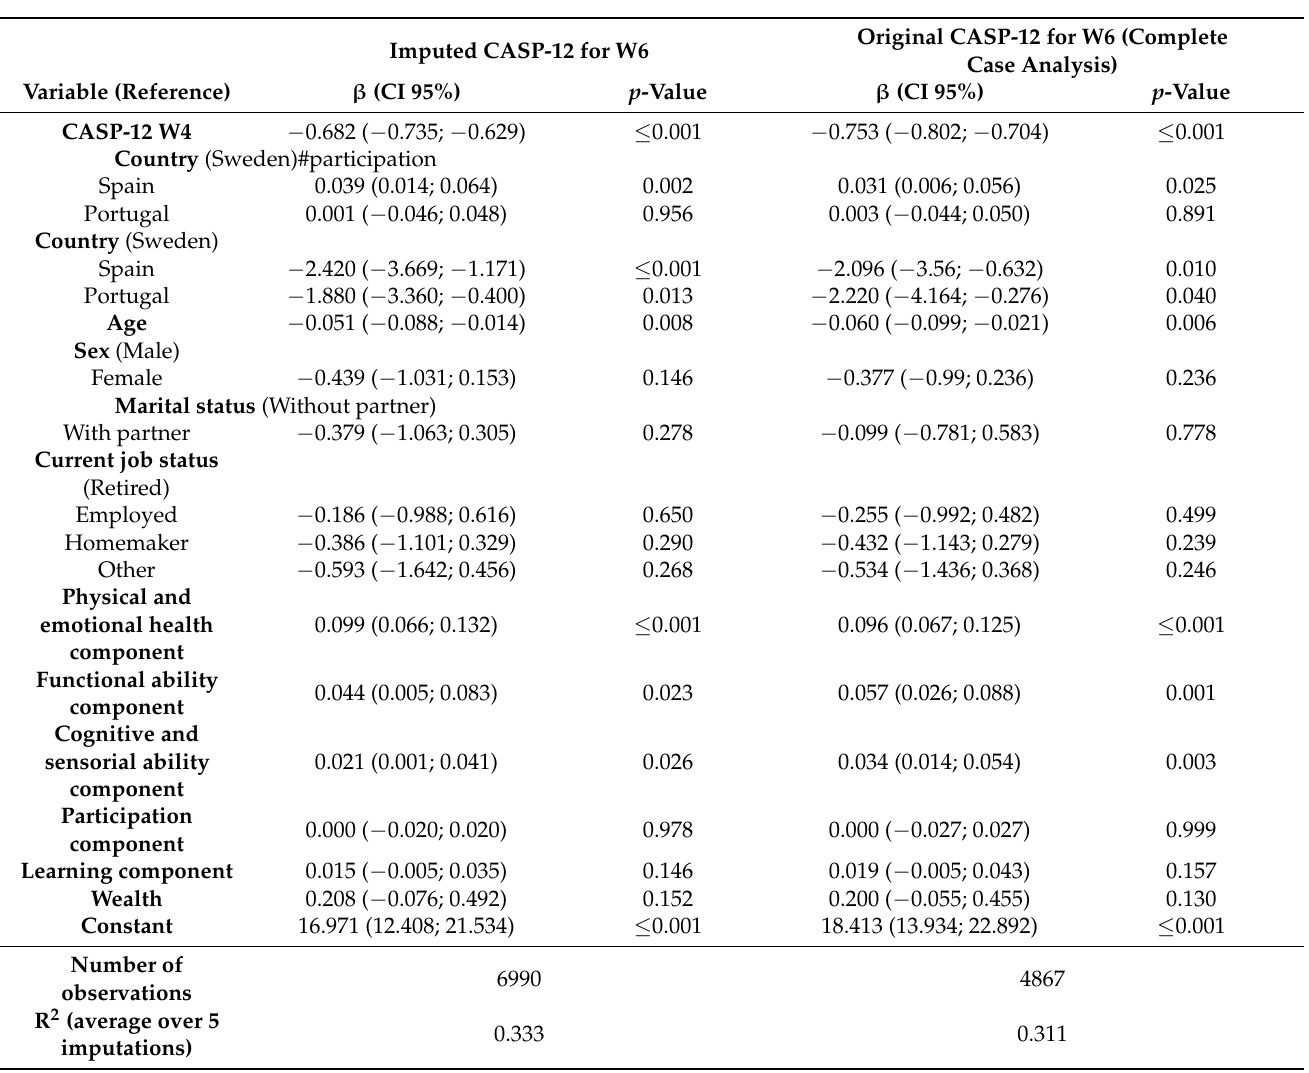
Table 4. Multiple linear regression of changes in QoL (CASP-12) between W4 and